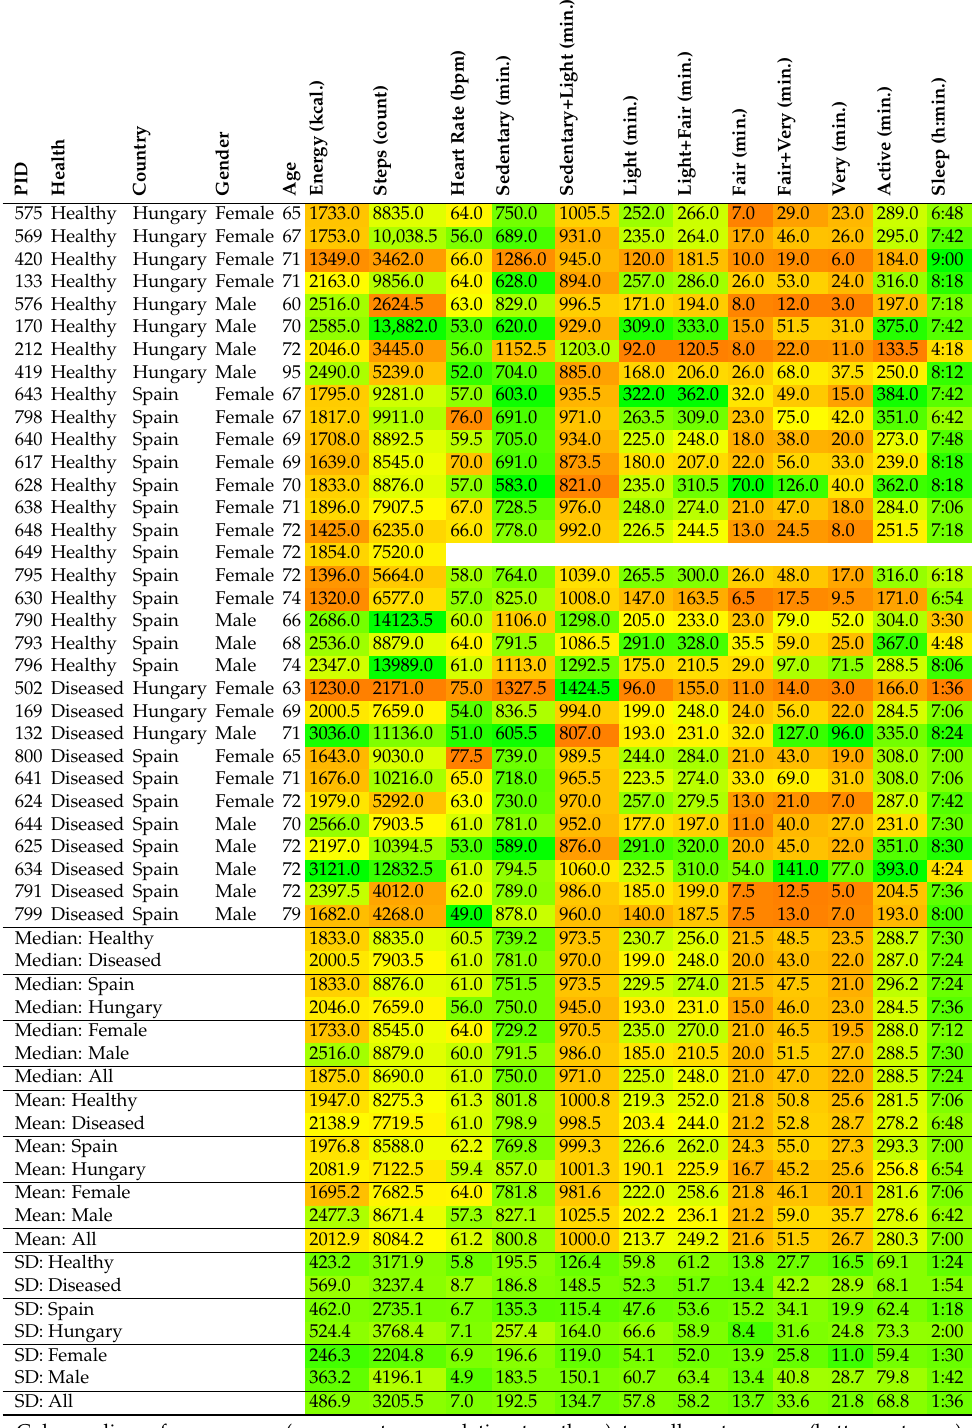
Color coding: from orange (worse outcome relative to others) to yellow to green (better outcome). Participant 649 only provided energy and